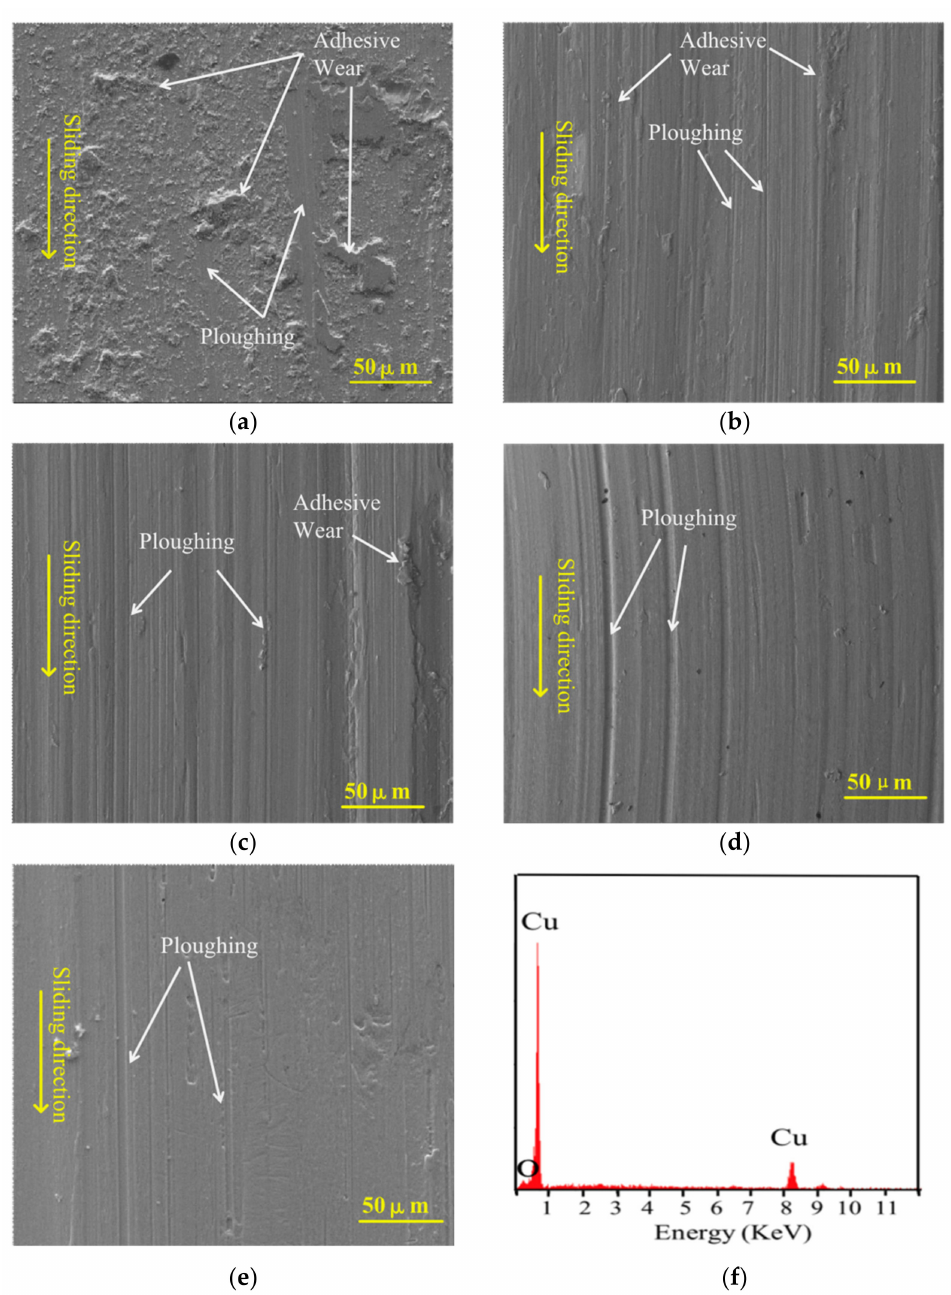
Figure 6. SEM images on the worn surfaces of Qbe-2 beryllium bronze pins working under different loads: ( a ) 15 N; ( b ) 25 N; ( c ) 35 N; ( d ) 45 N; ( e ) 55 N. The arrows in the pictures indicate the sliding direction. ( f ) EDX analysis on the